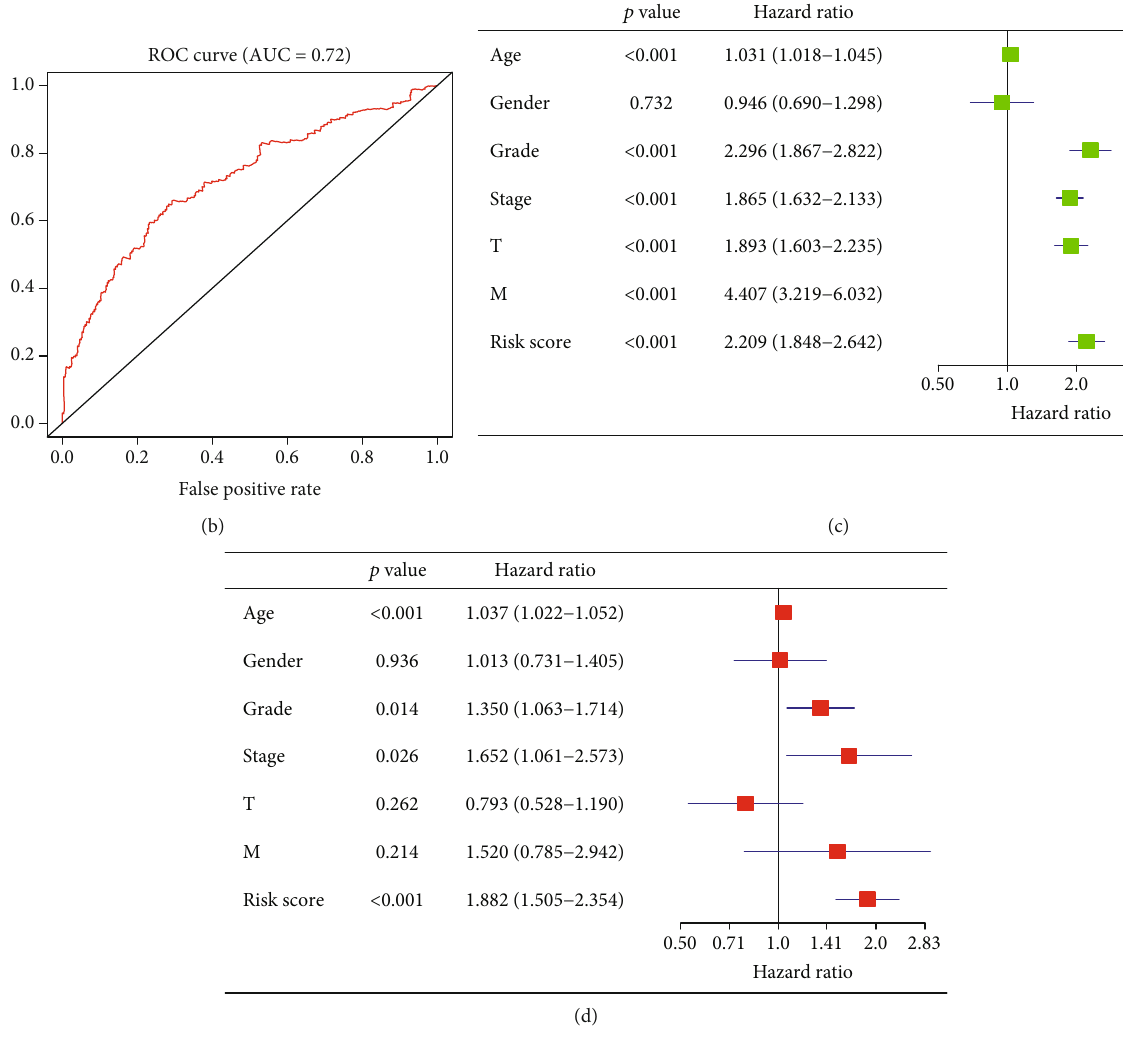
Figure 6: Prognosis value and accuracy of the risk signature. (a) Comparison of clinicopathological characteristics and expression of IGF2BP3, IGF2BP2, HNRNPA2B1, and METTL14 between the two groups de fi ned by the risk signature. (b) ROC curve representing the e ffi ciency and accuracy of the risk signature: the ROC curve for 5-year survival prediction by risk signature (date from TCGA). (c) Univariate Cox regression analysis of the association between clinicopathological factors, risk score, and overall survival of patients from TCGA datasets. (d) Multivariate Cox regression analysis of the association between clinicopathological factors, risk score, and overall survival of patients from TCGA datasets. ∗ p < 0 : 05 , ∗∗ p < 0 : 01 , and ∗∗∗ p < 0 : 001